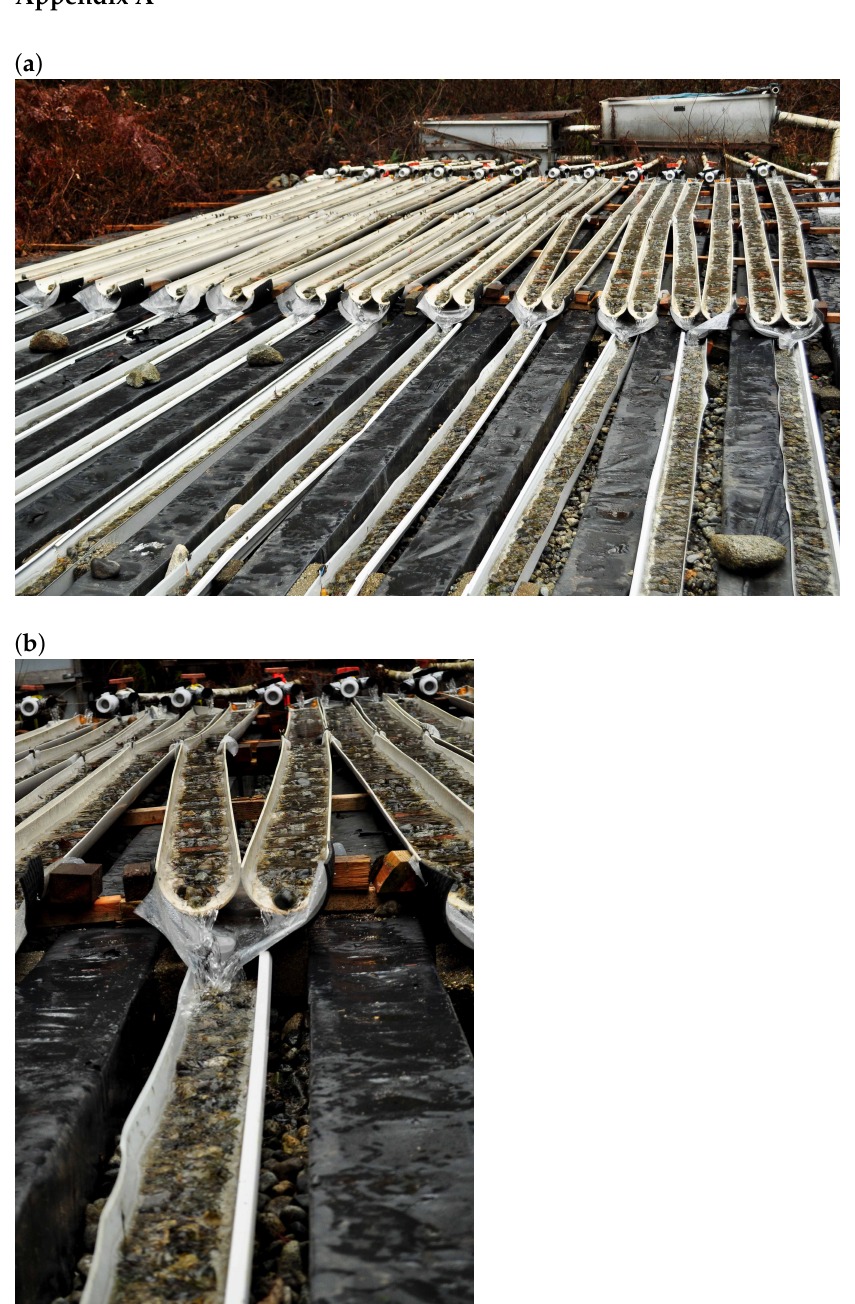
Figure A1. Photo of the experimental channel-network set-up consisting in 24 first-order channels converging in pairs to feed 12 second-order channels ( a ). Detail of a pair of first-order channels and their second-order recipient ( b